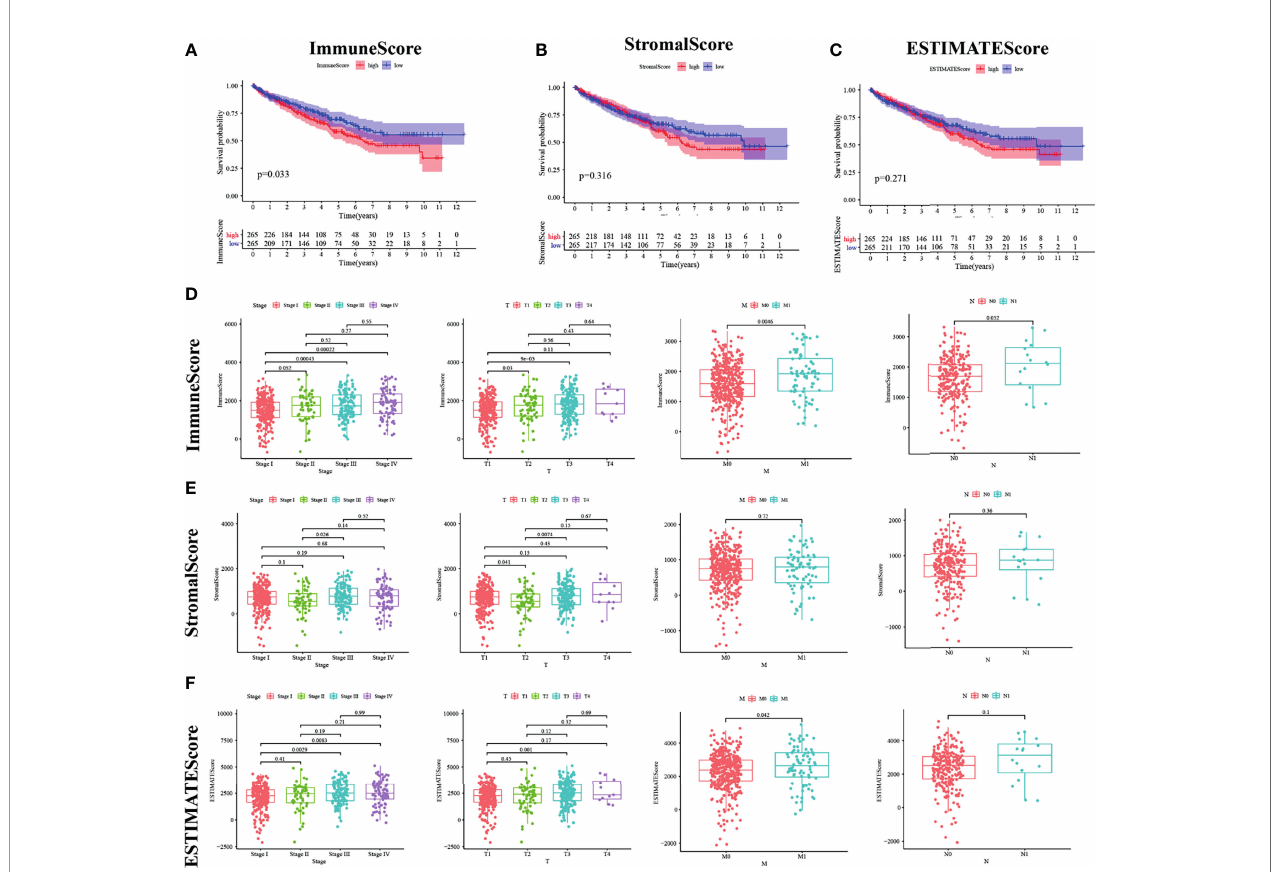
FIGURE 2 | ImmuneScore is correlated with survival of kidney renal clear cell carcinoma (KIRC) patients and clinical TNM staging. (A – C) According to the ESTIMATE algorithm, survival analysis of high and low ImmuneScore, StromalScore, and ESTIMATEScore. Panels (D – F) show the bar plot of the three scores with tumor clinical staging and TNM staging,